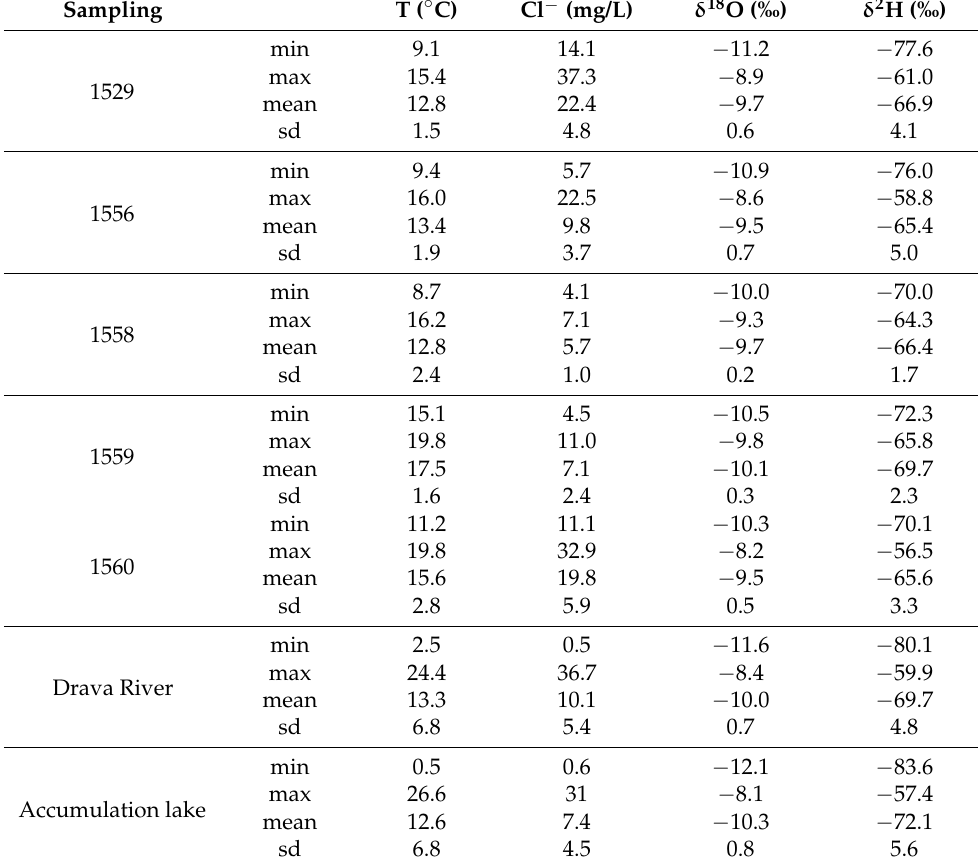
Table 4. Statistical values of temperature, chloride and δ 18 O in groundwater and surface water.